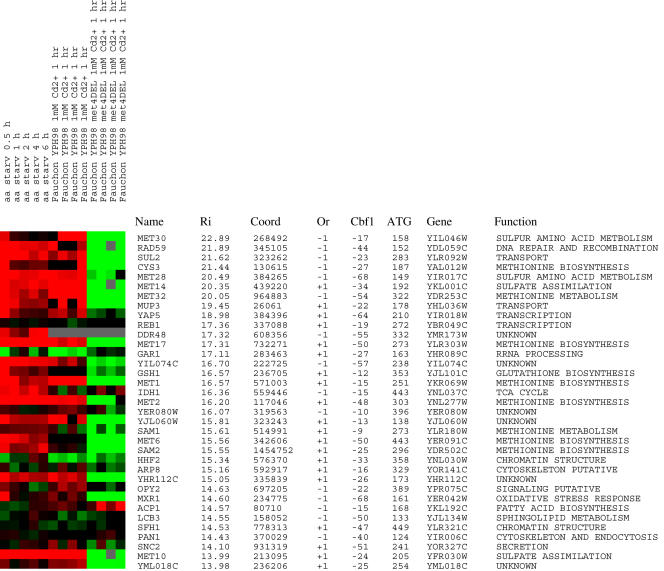
The top hits are involved in sulfur amino acid biosynthesis.These are the top hits according to our optimal spacing values. The first 9 columns are data for experiments that should induce the expression of Met4 regulated genes and give a red pattern. The last 4 columns we expect to see a decrease in expression of Met4 regulated genes and give a green pattern. Experiment information for each column is reported vertically above each column. Each row corresponds to a different gene followed by its common name, its flexible information (Ri), the coordinate of the Met31 binding site in the S. cerevisiae genome, the orientation of the Met31 matrix, the distance Cbf1 is upstream of Met31, the distance the gene start is downstream of Met31, the gene name according to its annotation in the yeast genome, and a description of its function.